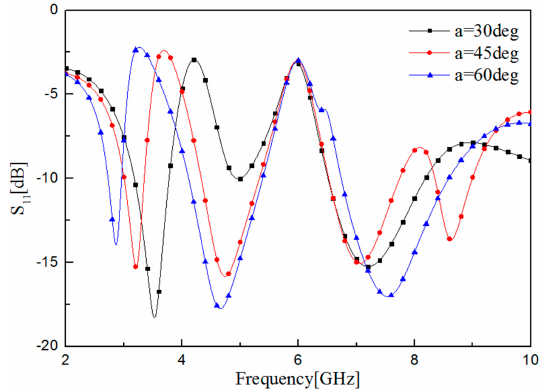
Figure 4. Effect of parameter α on the simulated return loss.